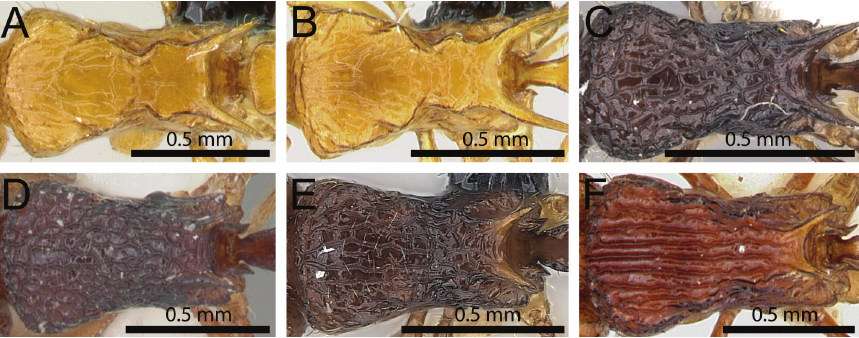
Figure 22. Mesosoma in dorsal view. A T. norvigi (CASENT0489037) B T. shamshir (CASENT0467696) C T. nosybe (CASENT0422207) D T. ranarum (CASENT0102392) E T. alperti (CASENT0042547) F T. isectum